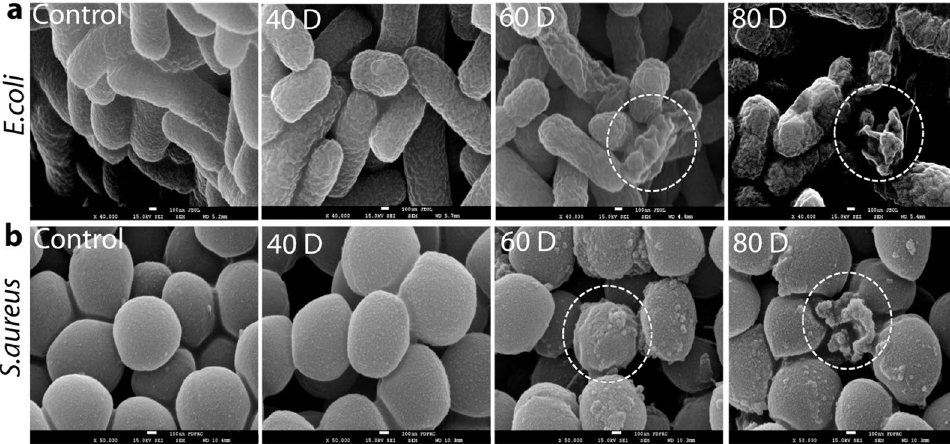
Figure 6. Analysis of cell morphology of ( a ) E. coli and ( b ) S. aureus bacterial strains after various discharges of microwave radiation.